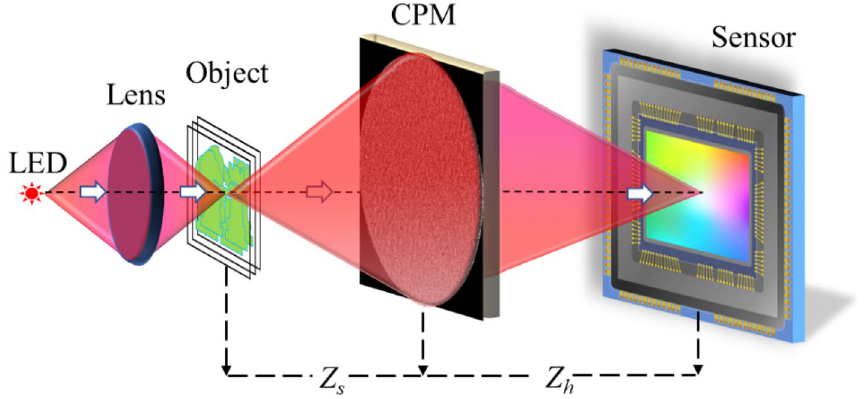
Figure 9. Schematic representation of the optical configuration of sparse chaotic I-COACH